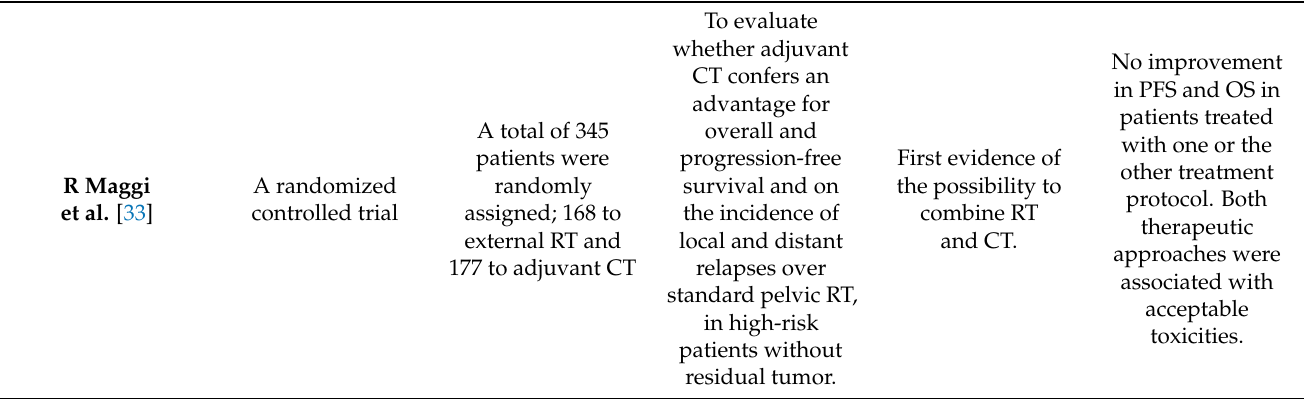
Table 2. Randomized trial concerning high-intermediate